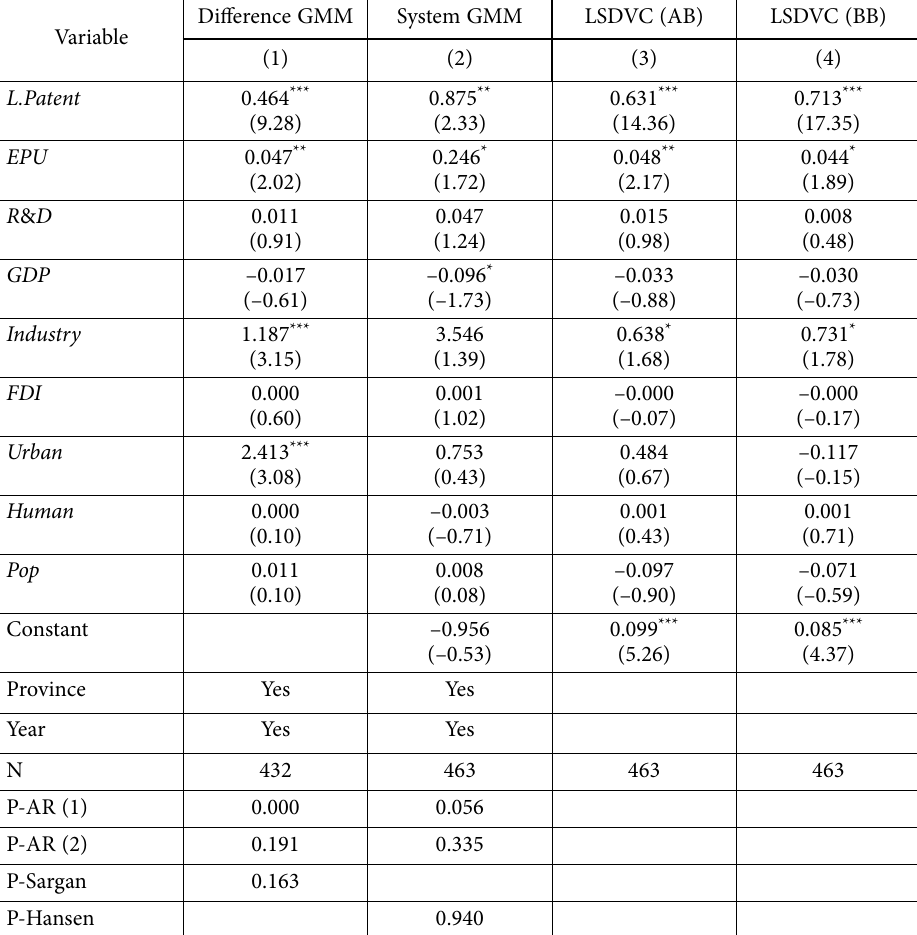
Table 9. Robustness tests: GMM and LSDVC estimators